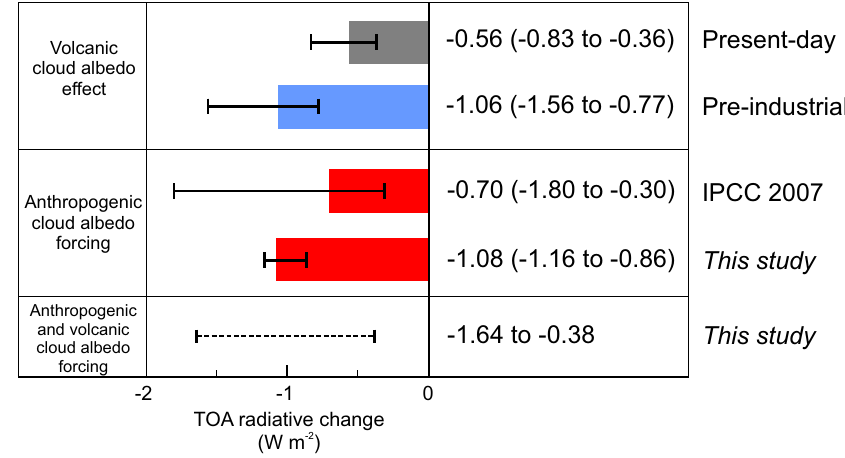
Fig. 9. Summary of results showing the effect of uncertain volcanic sulphur emissions on the global annual mean cloud albedo effect induced by volcanic degassing and the anthropogenic cloud albedo forcing. The grey and blue bars show the magnitude and the uncertainty range for the volcanic cloud albedo effect for present-day (PD) and pre-industrial (PI), respectively. In the central panel, the top red bar shows the magnitude of the anthropogenic cloud albedo forcing as estimated by IPCC (Forster et al., 2007) based on a range of modelling studies using different aerosol species and mixtures. The red bar directly below it shows the magnitude of the anthropogenic cloud albedo forcing estimated in this study with the uncertainty range arising from the − 50/ + 100% uncertainty in the volcanic source strength assuming the same volcanic flux strength over the PI-PD period. In the bottom panel, the dashed error bar shows the uncertainty range for the magnitude of the total cloud albedo forcing (i.e. combined volcanic and anthropogenic) assuming a change in the volcanic sulphur flux strength over the PI-PD